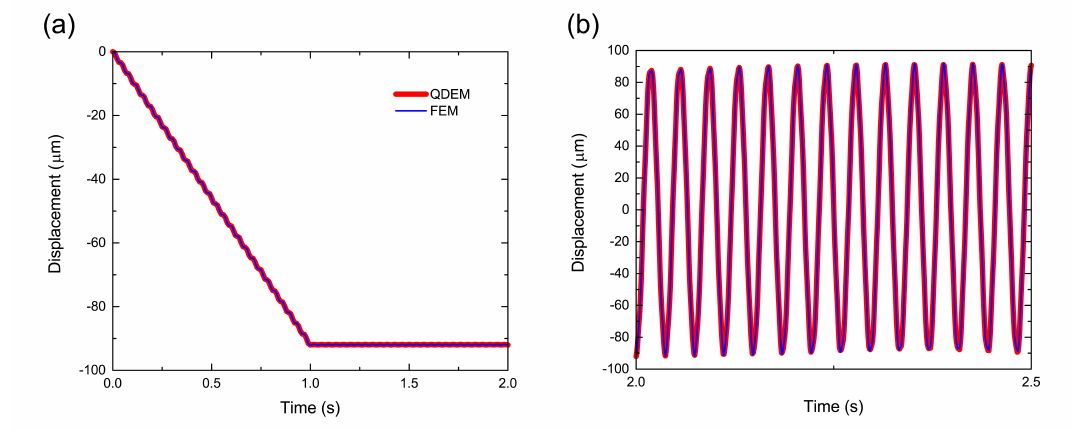
Figure 2. Time variations of displacement at the center of the cantilever free end ( a ) under loading and ( b ) after